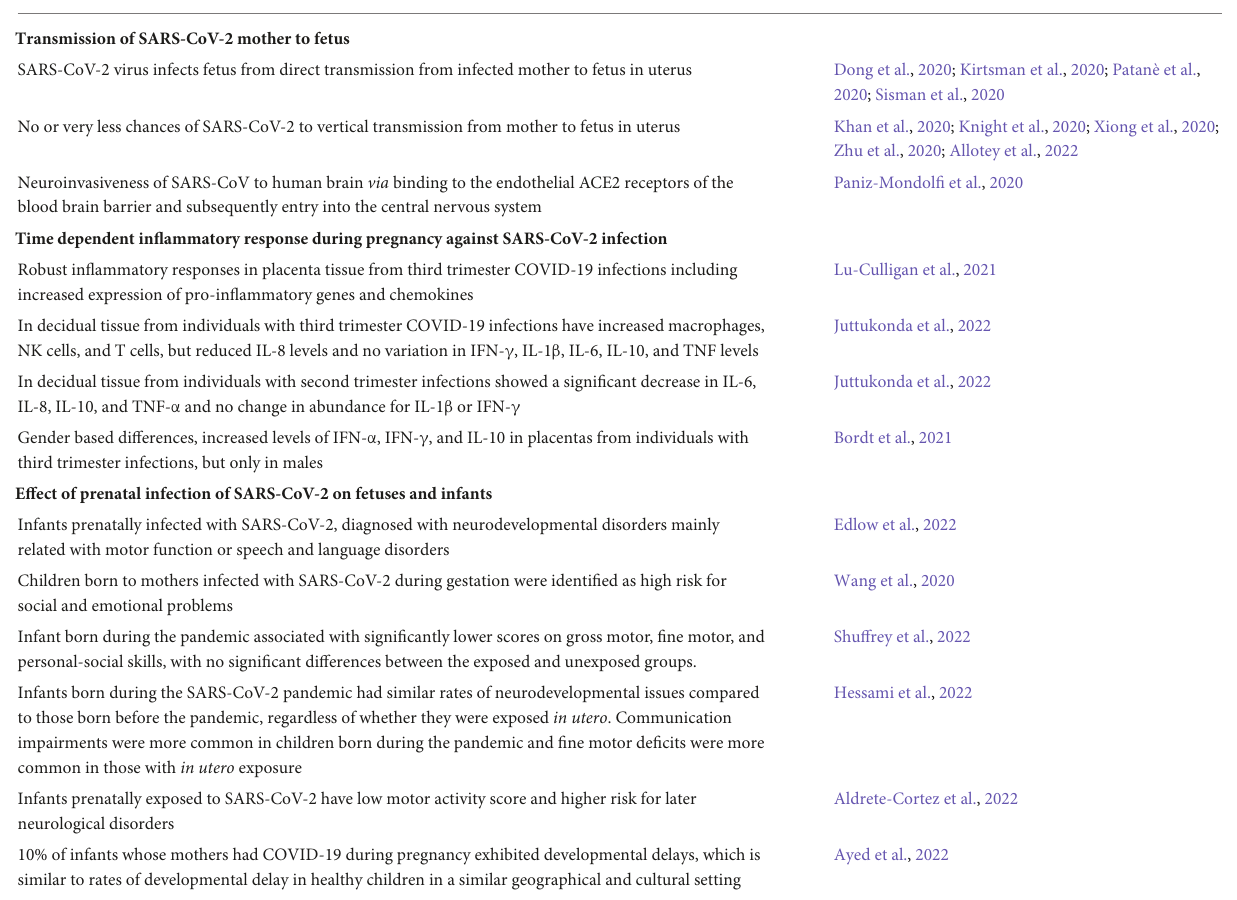
TABLE 1 Effect of maternal SARS-CoV-2 infection on offspring neurodevelopment.